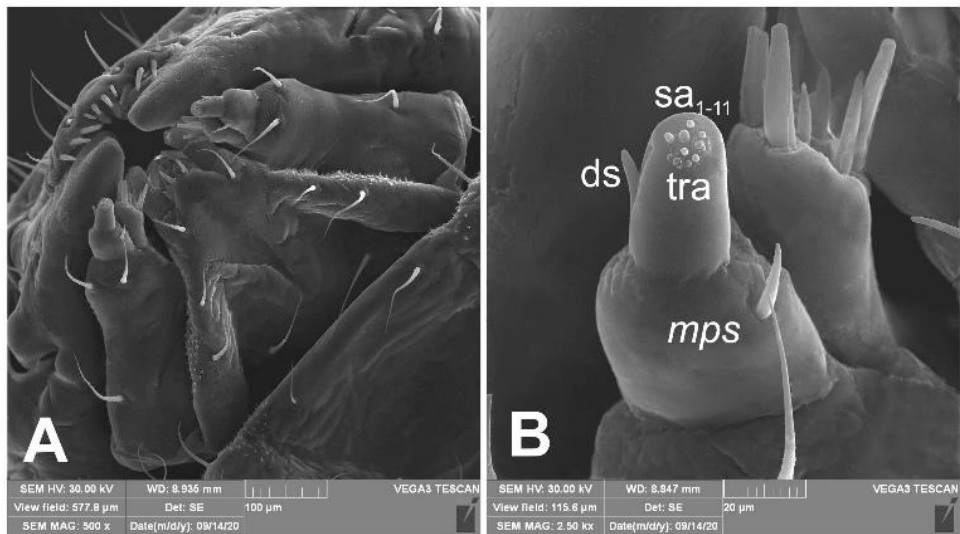
Figure 11. Euryommatus mariae mature larva, maxillolabial complex (SEM micrographs). ( A ) Maxillolabial complex, ventral aspect, SEM photo; ( B ) apical part of right maxilla, lateral aspect, SEM photo (ds—digitiform sensillum, mps —maxillary palp seta, sa—sensillum ampullaceum, sb—sensillum basiconicum, tra—terminal receptive area).